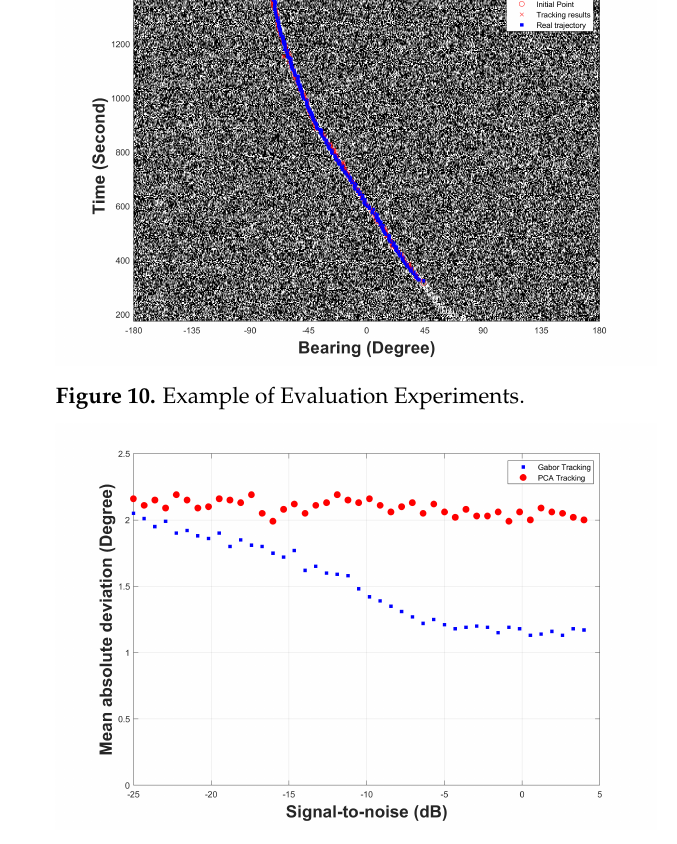
Figure 11. Evaluation of Accuracy